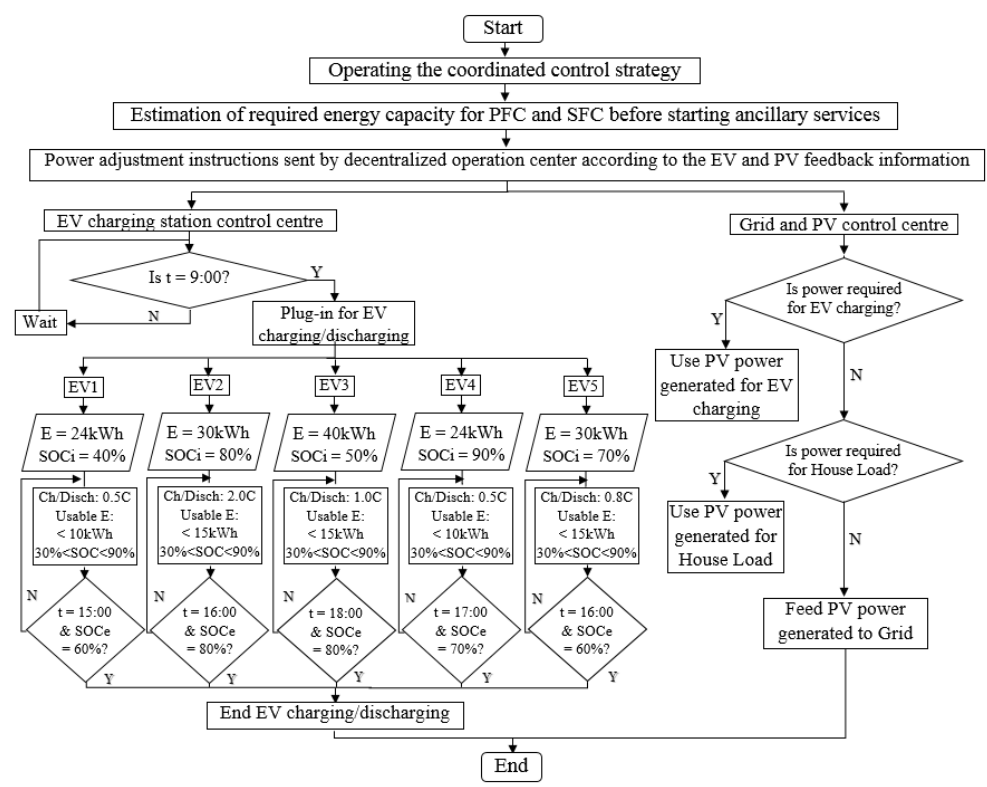
Figure 11. Coordinated control algorithm for frequency control.